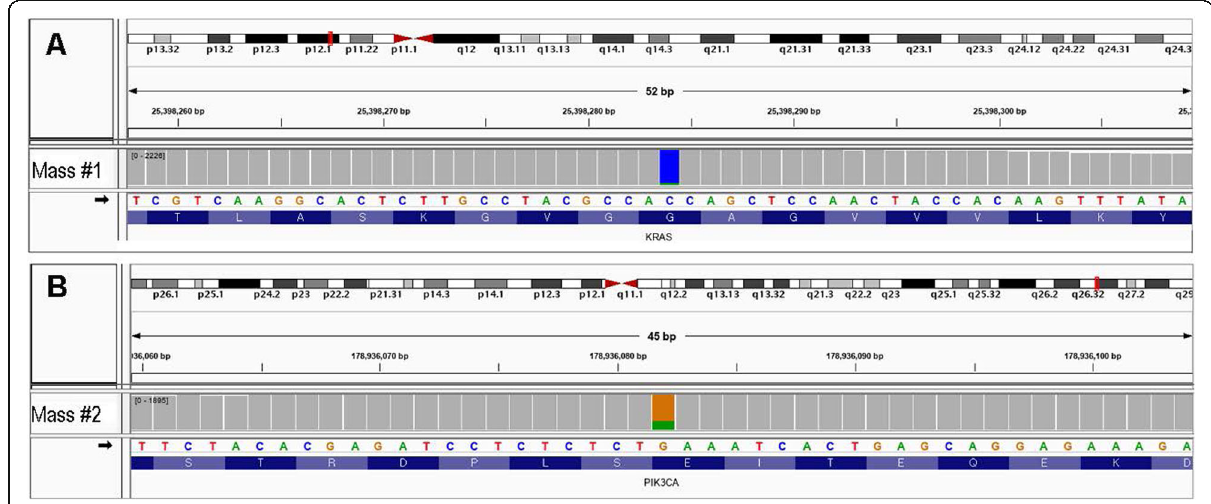
Fig. 3 Integrative Genomics Viewer (IGV) snapshot of human KRAS gene location with missense mutation identified in papillary renal neoplasm with reverse polarity. The mutation is clustered in p.Gly12Val ( a ). IGV snapshot of human PIK3CA gene location with missense mutation identified in clear cell renal cell carcinoma. The mutation is clustered in p.Glu542Lys ( b )